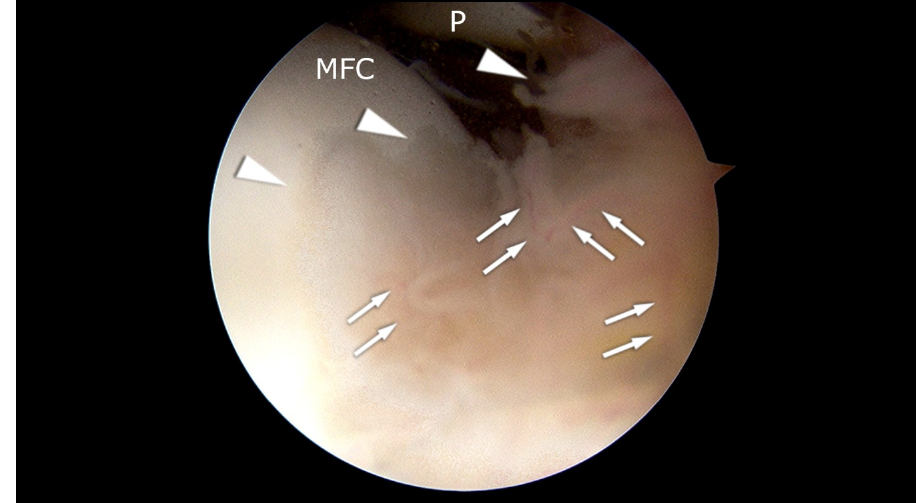
Figure 1. Arthroscopic appearance of the patient with synovitis and initial pathologic changes in the cartilage of the medial femoral condyle (MFC). Arrowheads: hypertrophic synovium. MFC: cartilage of the medial femoral condyle. P: patella. Arrows: blood vessels. The picture comes from our own material.